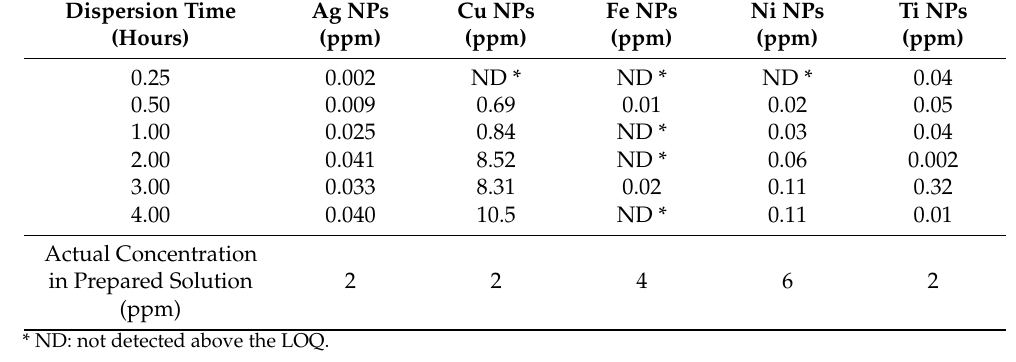
Table 3. Detected concentration of single element solutions MNPs.